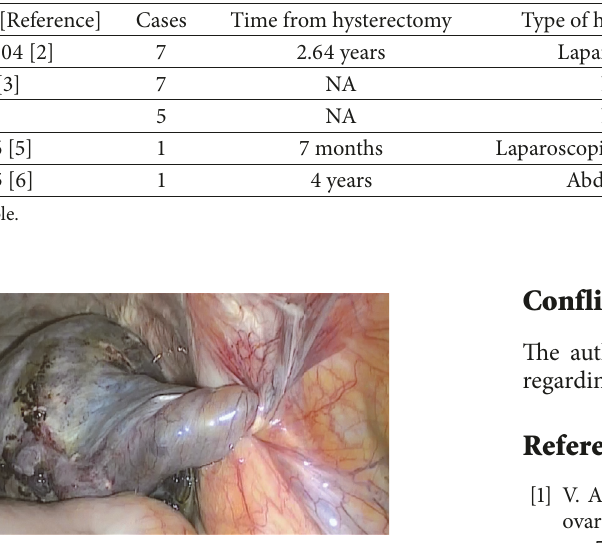
Table 1: Ovarian torsion after hysterectomy.